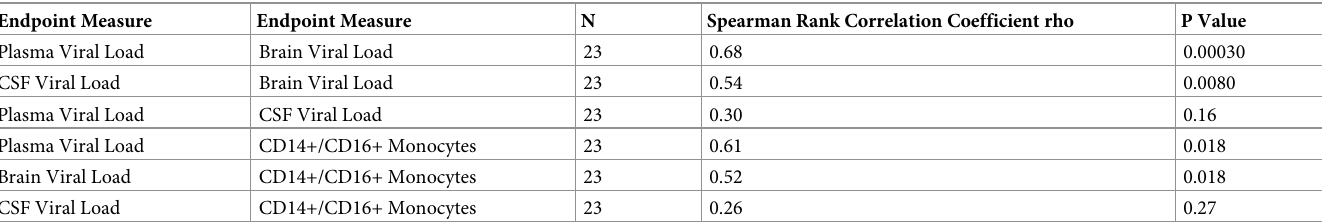
Table 2. Correlation between viral loads in different compartments and CD14+/CD16+ monocytes.